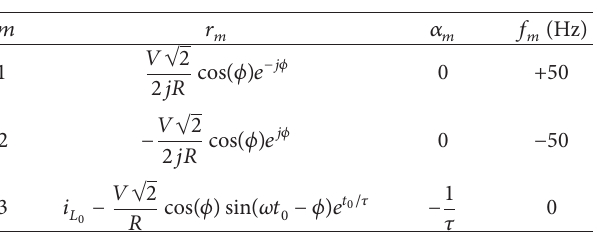
Table 2: The residues, attenuation factors, and frequencies of the series RL load.